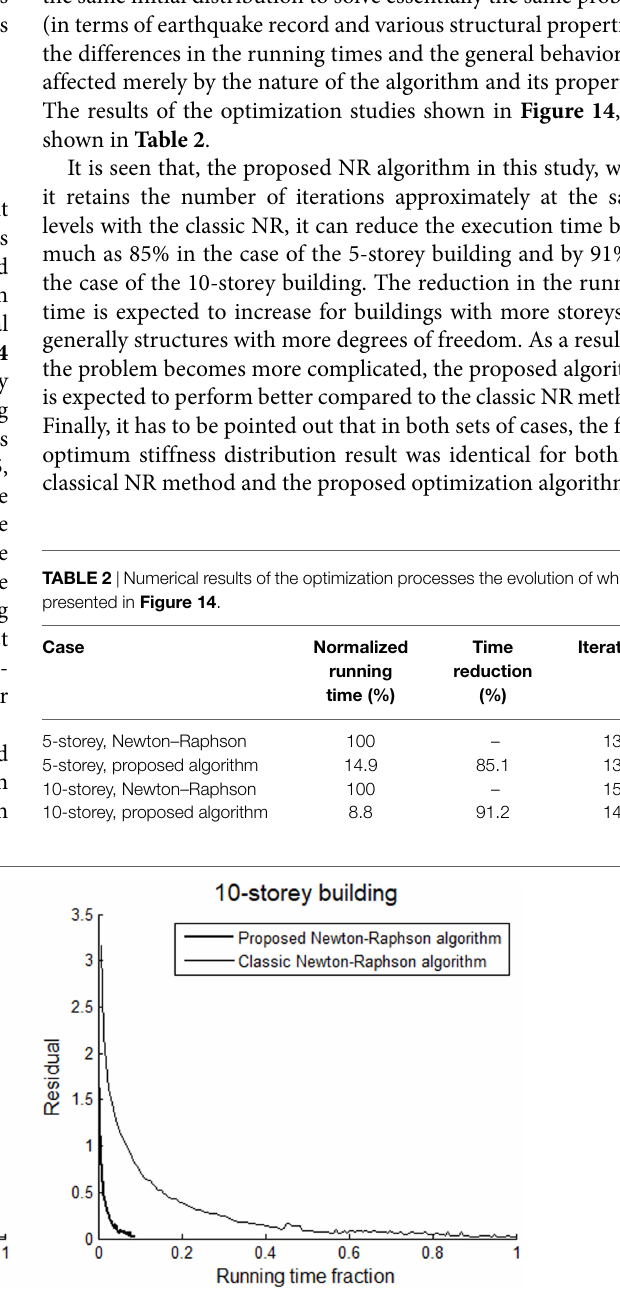
FIGURE 14 | Evolution of the standard deviation of the hysteretic energy distributions during various optimization processes for the classic N–R optimization procedure and the proposed N–R optimization procedure, for 5- and 10-storey shear buildings with f 0 = 2Hz, ξ = 5%, (cid:22) u y = 0.1 and f 0 = 1Hz, ξ = 5%, (cid:22) u y = 0.04, respectively, subject to the El Centro earthquake